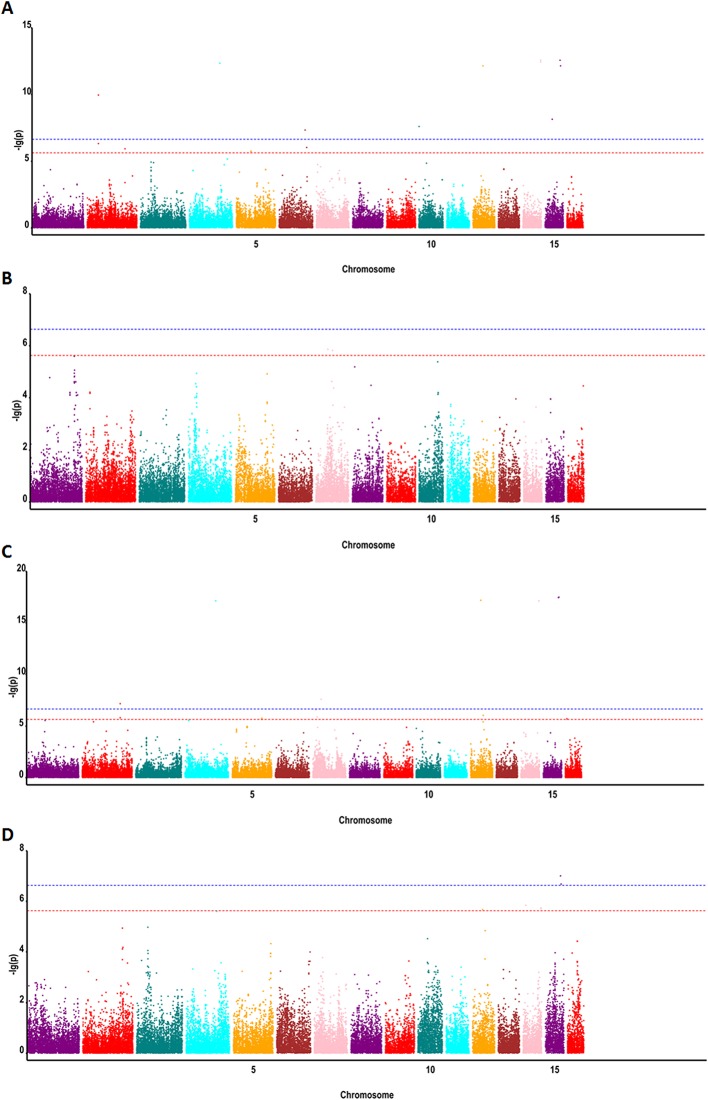
Genome-wide associations between SNP markers and fatty acid contents in oil palm (E. guineensis) using MLM: (A) Manhattan plot for oil content, (B) Manhattan plot for palmitic acid content (C16:0), (C) Manhattan plot for linoleic acid content (18:2), and (D) Manhattan plot for oleic acid content (18:1). Red (6.3) and blue (7.3) lines indicate P-value cutoffs FDR of 0.1 and 0.01, respectively.